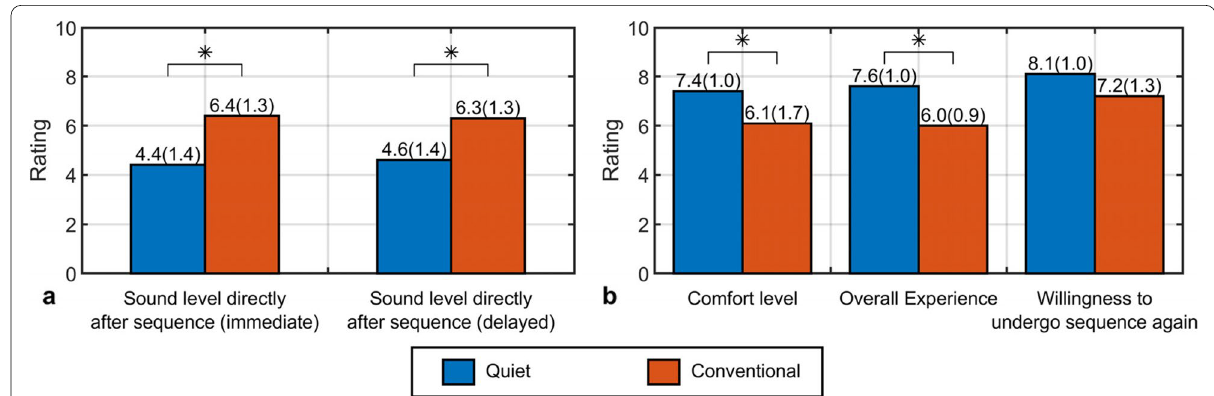
Fig. 4 a Means (SD) of reported sound level ratings immediately after the sequence and after the whole examination (delayed) for the quiet compared to the conventional sequence. b Means (SD) of comfort level, overall experience and willingness to undergo sequence again ratings for the quiet compared to the conventional sequence. Asterisk indicates statistical significance ( p < 0.05; Wilcoxon signed-rank test). SD Standard